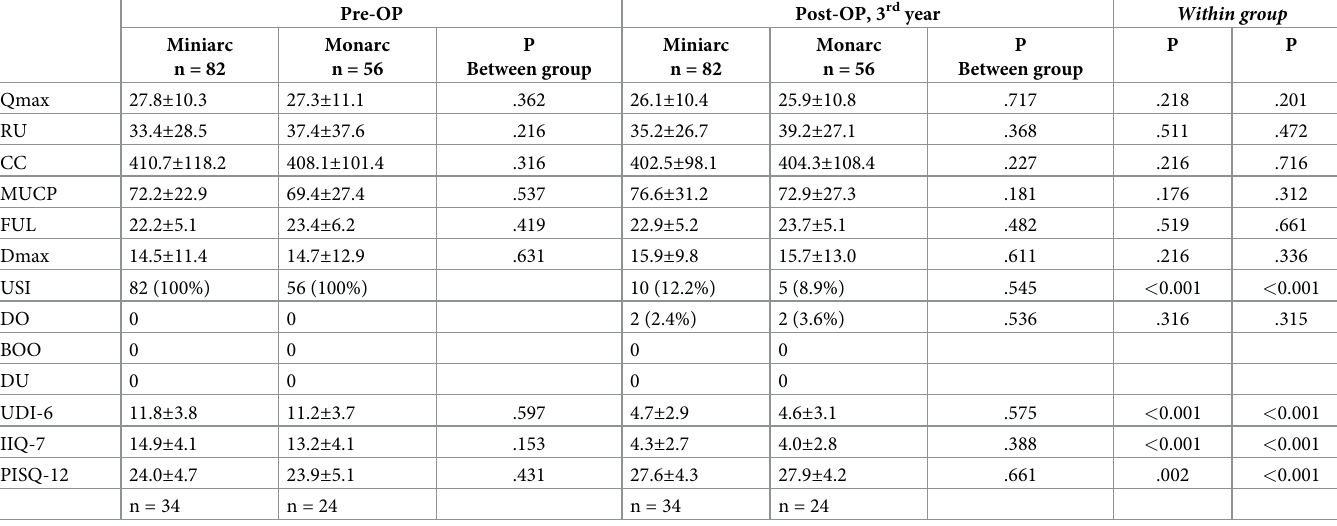
Table 3. Pre and post surgery urodynamics UDI-6, IIQ-7, PISQ-12 comparison between Miniarc and